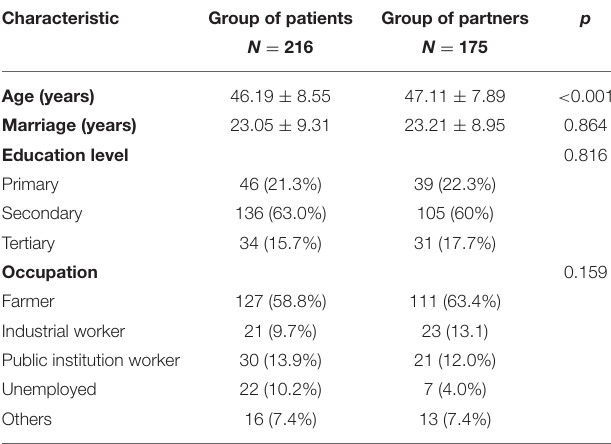
TABLE 1 | Social-demographic variables, clinical characteristics of